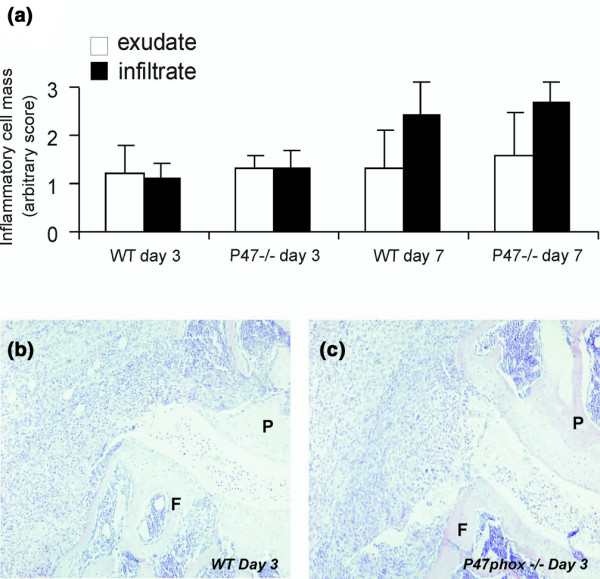
Inflamed knee joints, various days after IFN-γ-stimulated ICA in p47phox-/- mice and controls. The numbers of cells present in the synovium (infiltrate) and in the joint cavity (exudate) were determined on an arbitrary scale from 0 to 3: 0, no cells; 1, few; 2, moderate; 3, maximal. (a) Numbers of cells; (b) wild-type controls; (c) p47phox-/- mice. The number of cells was determined by two blinded observers. Data are means ± SD for eight animals. Significance was tested with the Wilcoxon rank test (*P < 0.05). Original magnifications × 100. F, femur; P, patella. Note that there is a comparable cell mass in arthritic knee joints of p47phox-/- mice and wild-type controls.